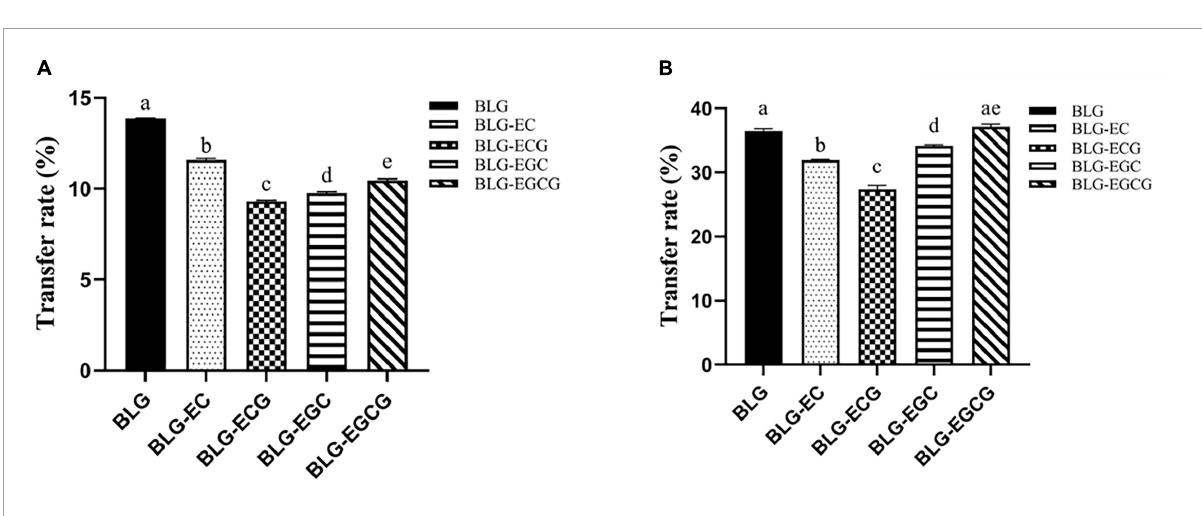
FIGURE5 Transport efficiency of digestion of Caco-2 monolayer model and M cell model. (A) Caco-2 monolayer model; (B) M cell model. Different superscript letters denote significant differences ( p <